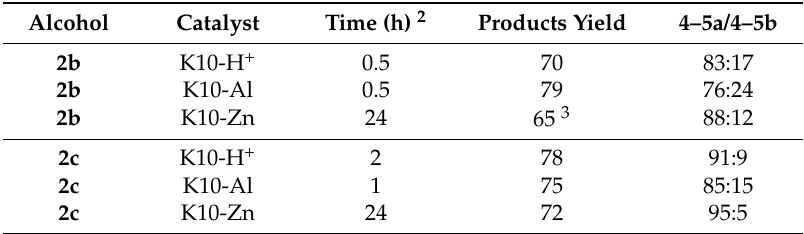
Table 3. Comparison of the synthetic methodologies for the synthesis of GMEs ( 3 – 5a and 3 – 5b